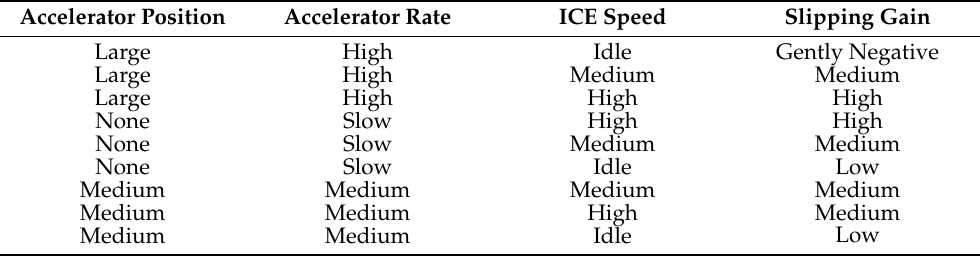
Table 3. Driver intention